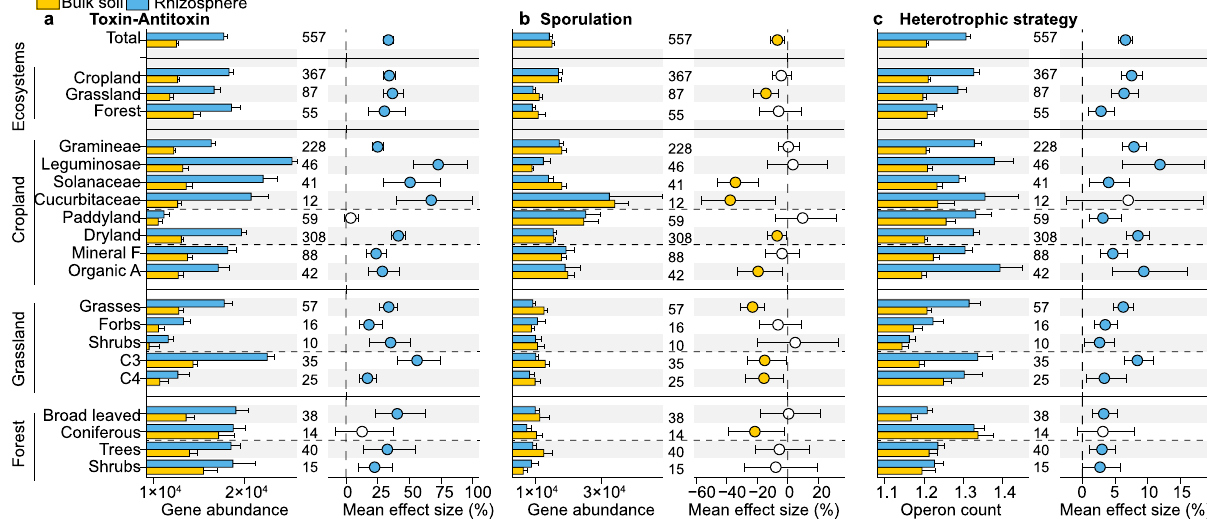
Fig. 4 Dormancy potentials and heterotrophic strategies of bacterial communities in the rhizosphere and bulk soils. a Differences in the abundances of toxin – antitoxin systems genes between communities in the rhizosphere and bulk soils; b differences in the sporulation factor abundances between communities in the rhizosphere and bulk soils; c differences in the weighted mean ribosomal operon copy numbers between communities in the rhizosphere and bulk soils. Bar charts re fl ect mean value and standard errors for each category. The error bars on the columns represent the standard errors (SE). Dots represent the percentage change in effect size between bacterial communities in the rhizosphere and bulk soils with 95% con fi dence intervals (CIs). Mean values <0 indicate a higher dormancy potential or heterotrophic strategy in bulk soil (yellow dots: depletion in the rhizosphere), while mean values >0 re fl ect a higher dormancy potential or heterotrophic strategy in the rhizosphere (blue dots). The intersection of the error bars and the zero line indicates that there is no signi fi cant difference between bacterial communities in the rhizosphere and bulk soils (open dots). Sample size is showed by number of data pairs for each group. Mineral F and Organic A indicate the types of fertilization, which are mineral-only fertilization and organic amendments, respectively. Source data are provided as a Source data fi